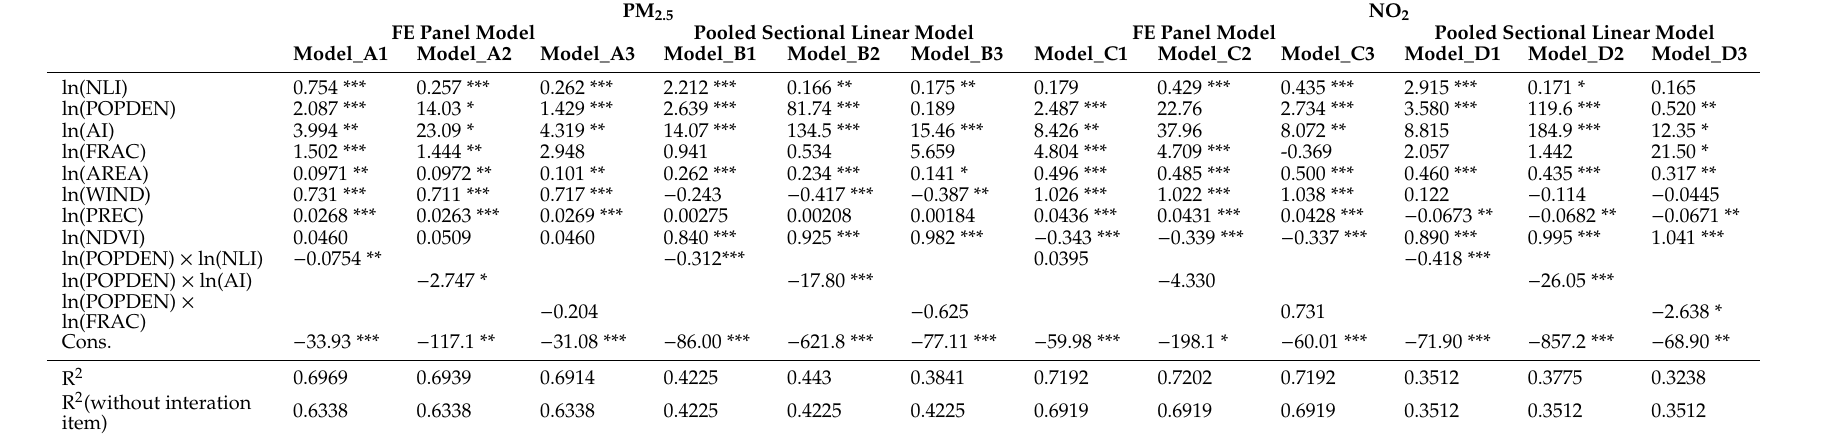
Table 4. Estimations of the FE panel models with di ff erent interaction